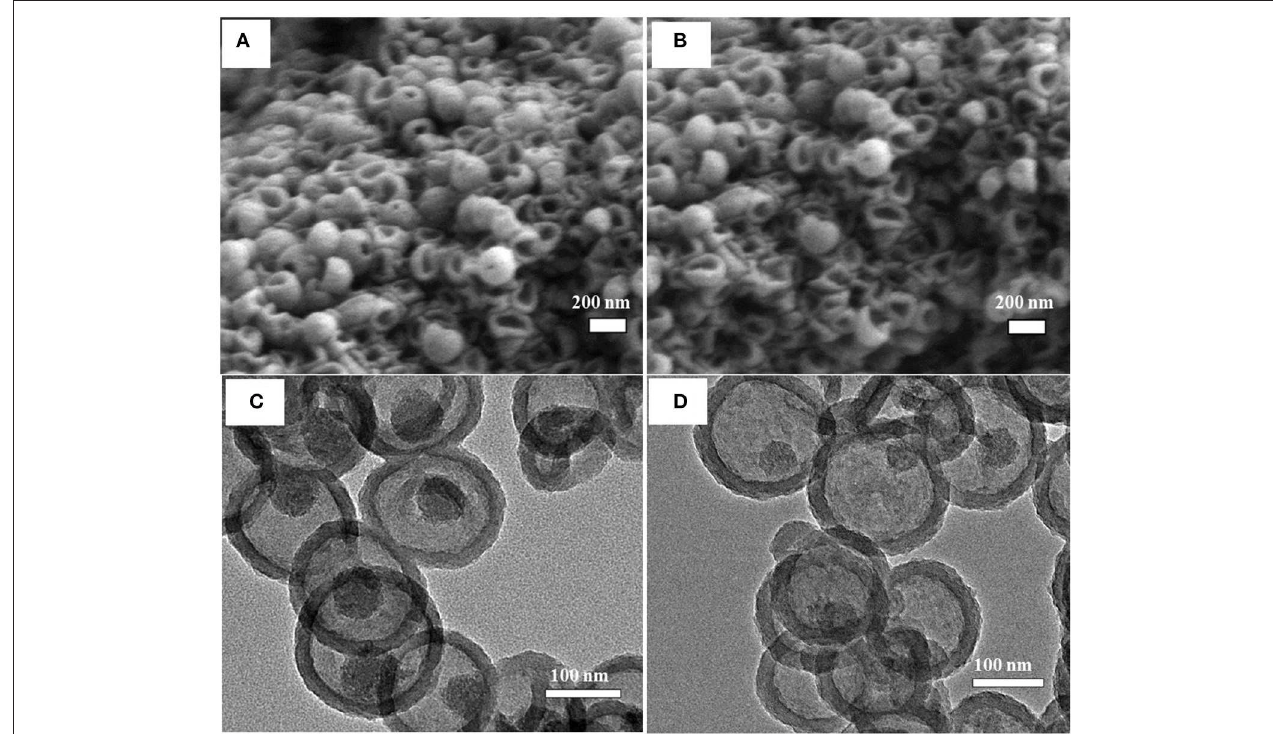
FIGURE 4 | SEM (A,B) and TEM (C,D) images of MSN@PDA with PDA thickness of 74nm that coated at 45 ◦ C after dispersed in water for 24h (A,C) and 48h (B,D) .